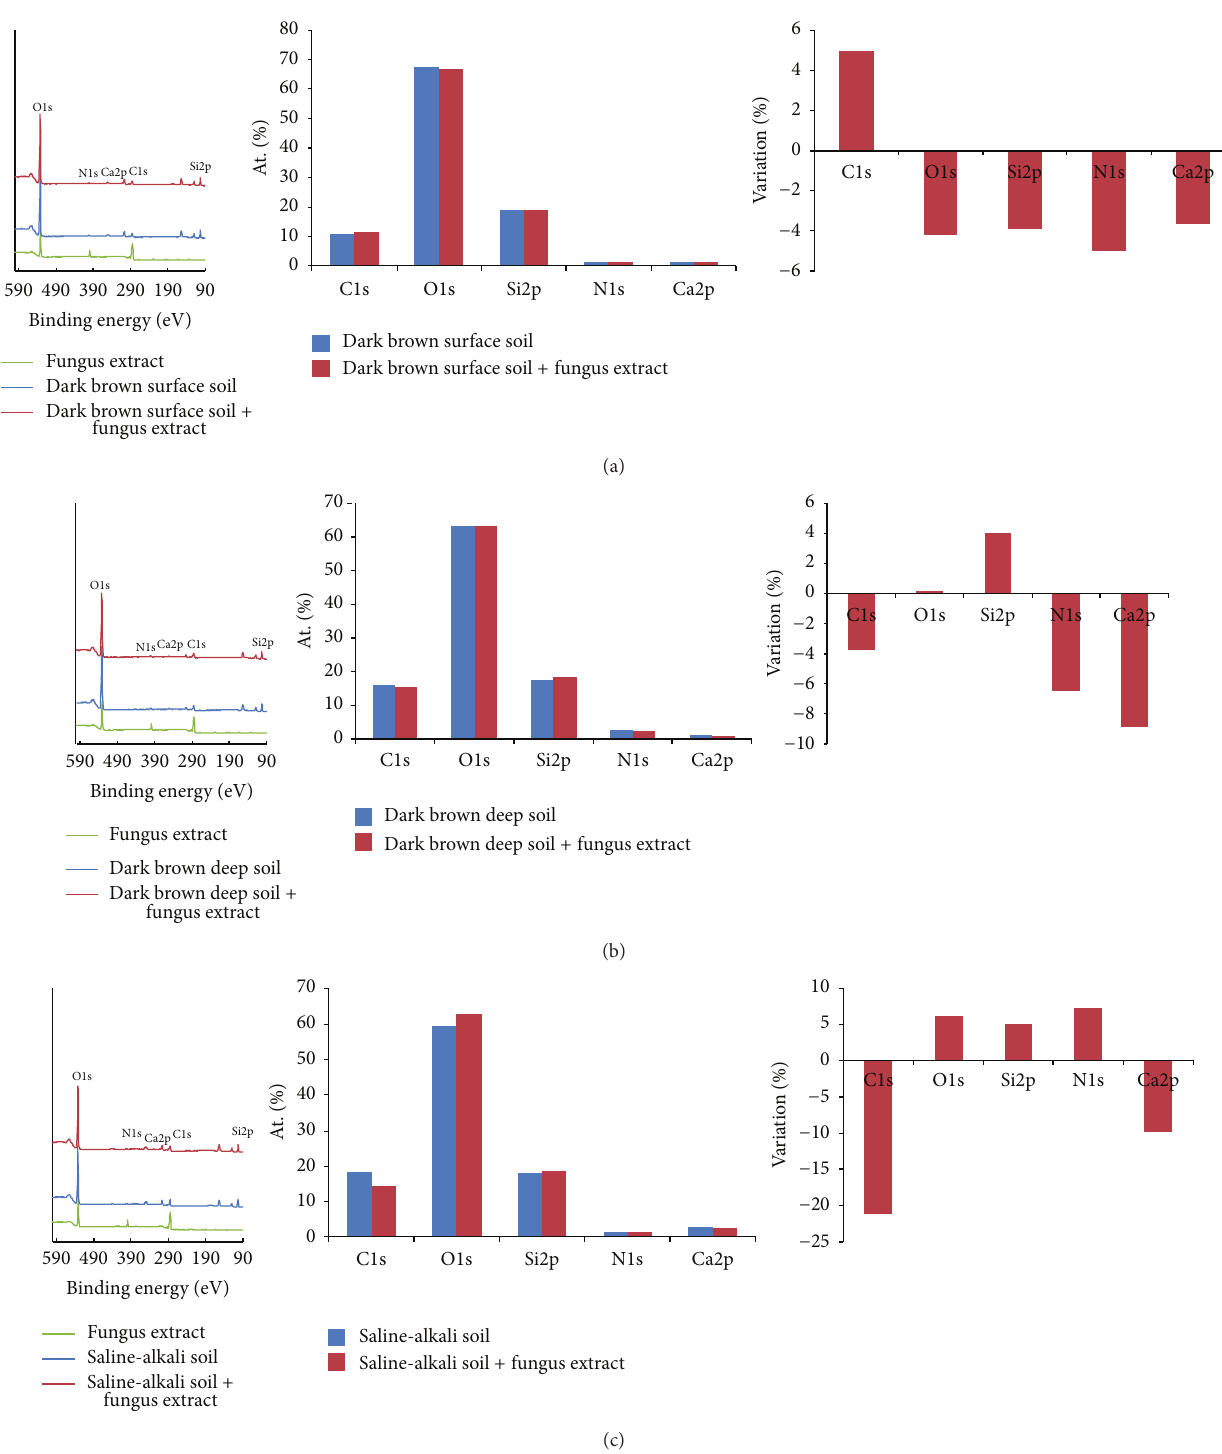
Figure 6: X-ray photoelectron spectroscopy results with and without fungus extract addition. The labels are the same as those for Figure 4. between ECM and plants. In the case of the ECM studied